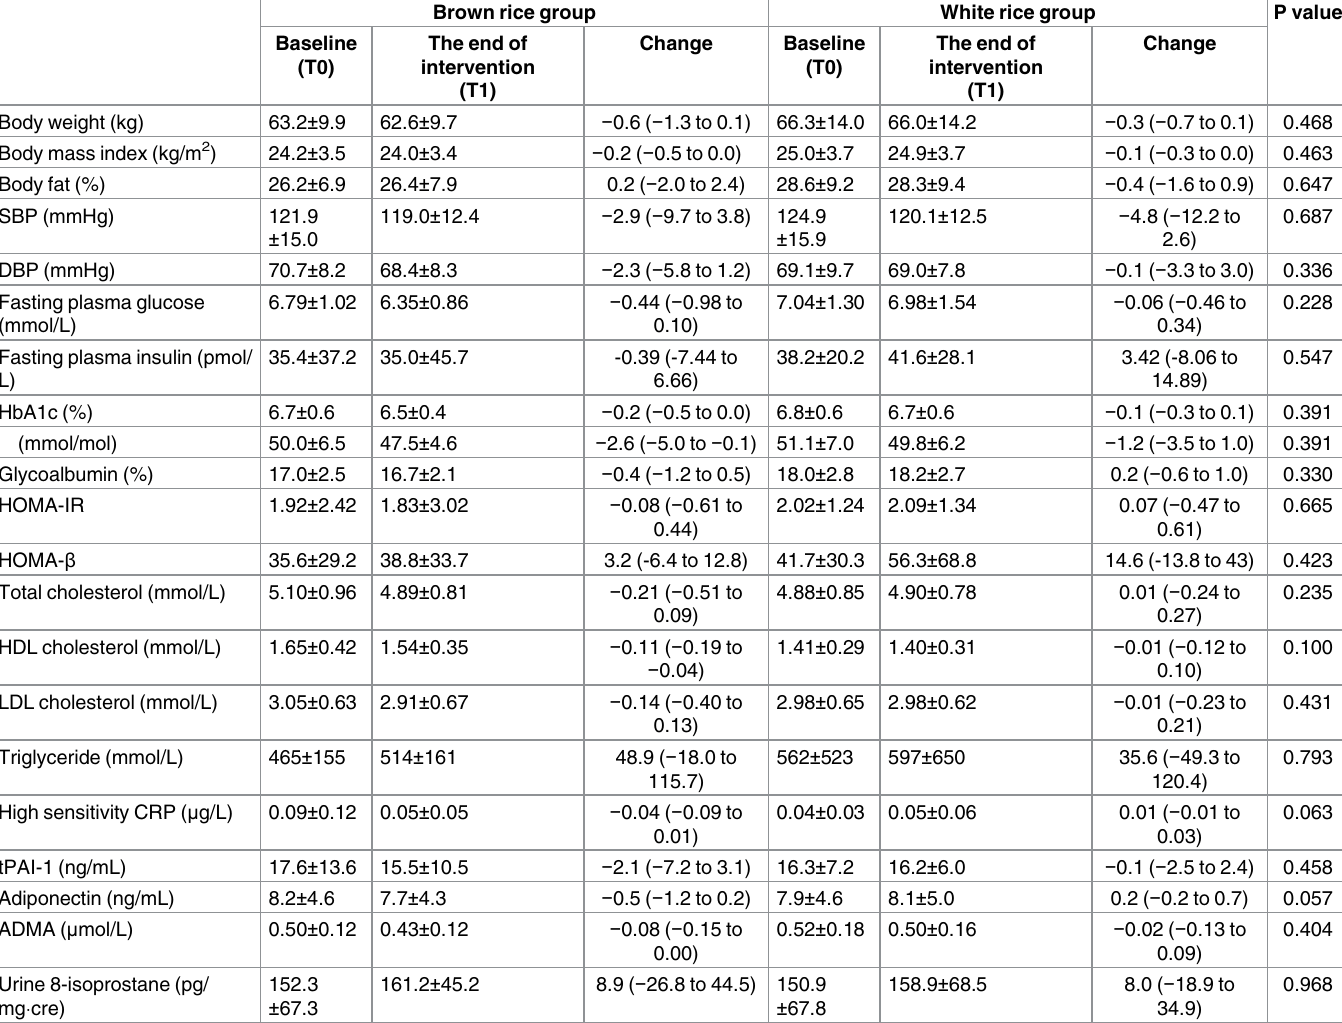
Table 3. Changes in metabolic variables in the brown rice and white rice diet